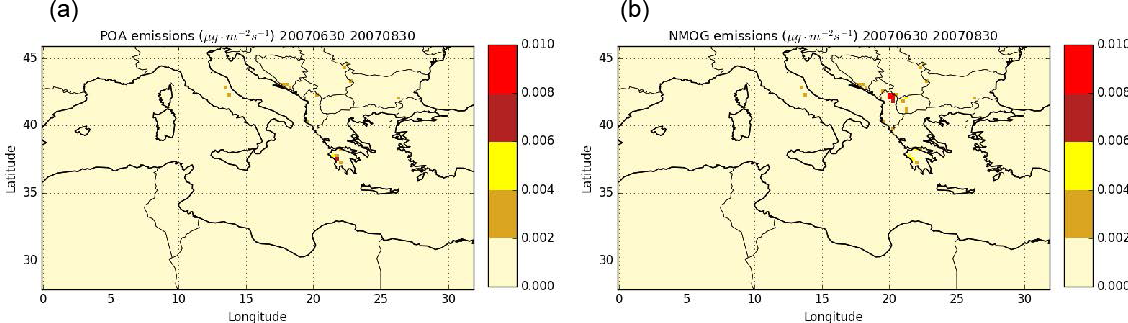
Figure 14. Daily mean POA (a) and NMOG (b) emissions from wildfires during the summer of